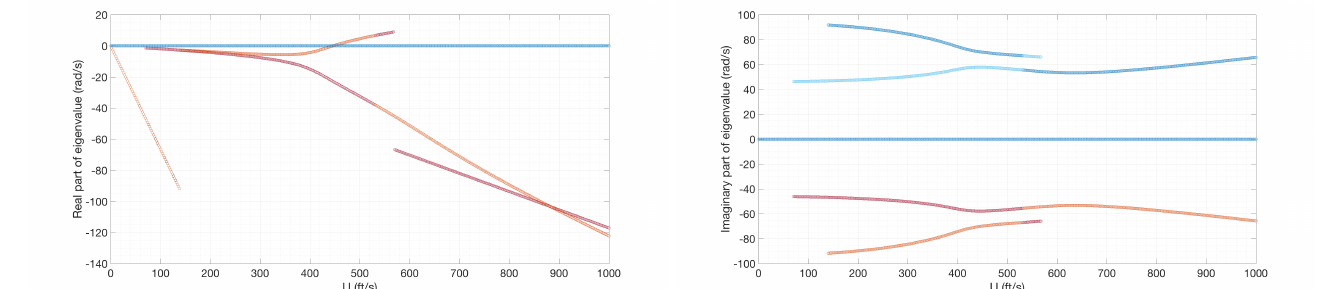
Figure 17. Eigenvalue analysis for the Goland wing.